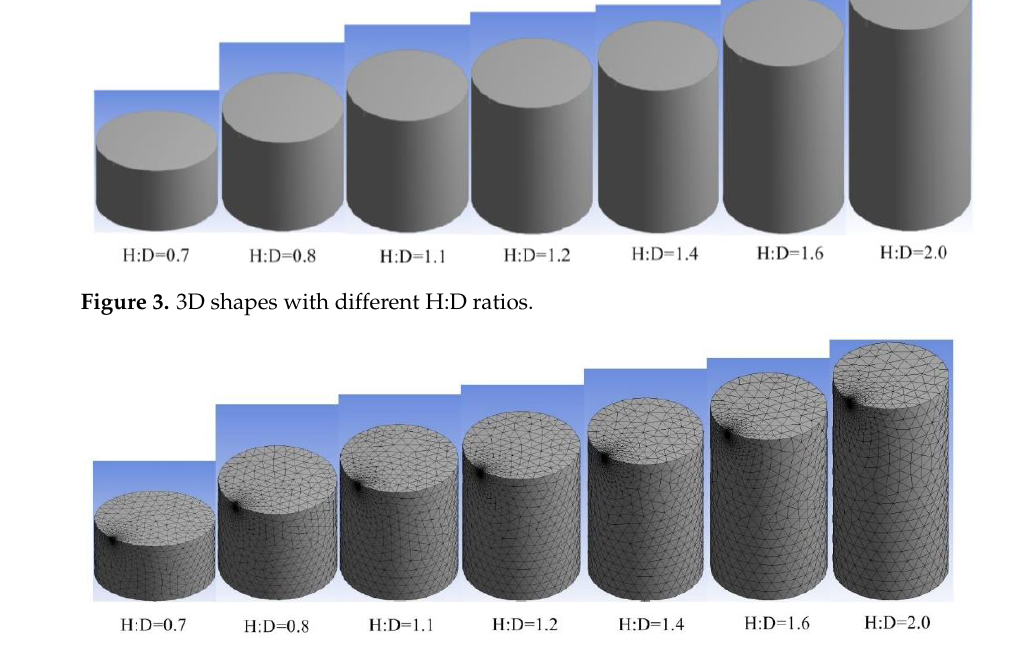
Figure 4. Unstructured grid of 3D shapes with different H:D ratios.